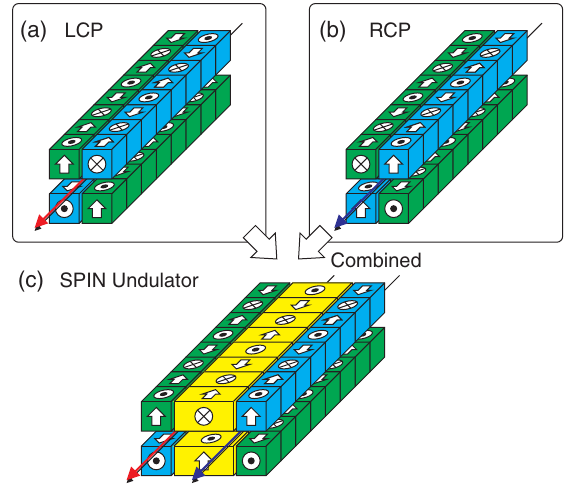
FIG. 3. Schematic illustration of the SPIN configuration: (a) RCP and (b) LCP configurations of the APPLE undulator are combined to form the configuration shown in (c). The helicity can be switched by changing the relative horizontal position between the electron beam and the